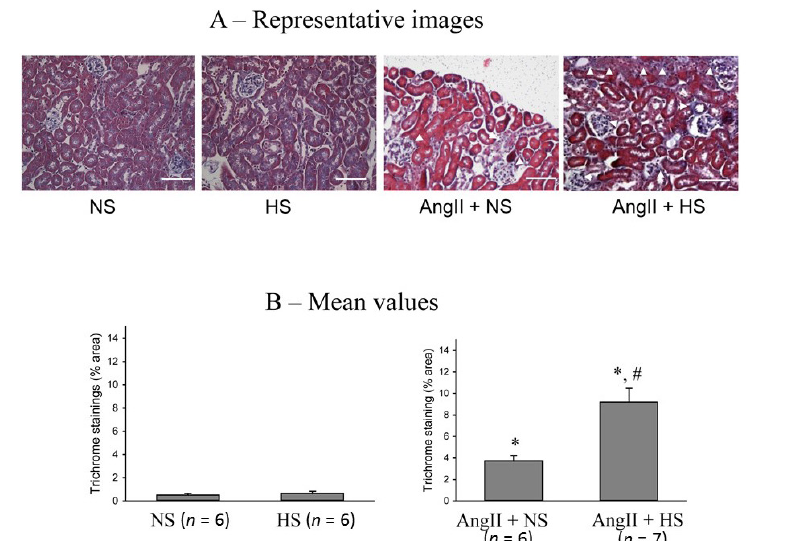
Figure 9. Renal interstitial fibrotic changes in the kidneys. (A) the representative images of renal slices using Gomori’s trichrome staining as denoted by white arrow heads and (B) the mean values of percent area of trichrome staining. The scale bar indicates 100 µm; * : P < 0.01 vs. NS; #: P < 0.05 vs. AngII +